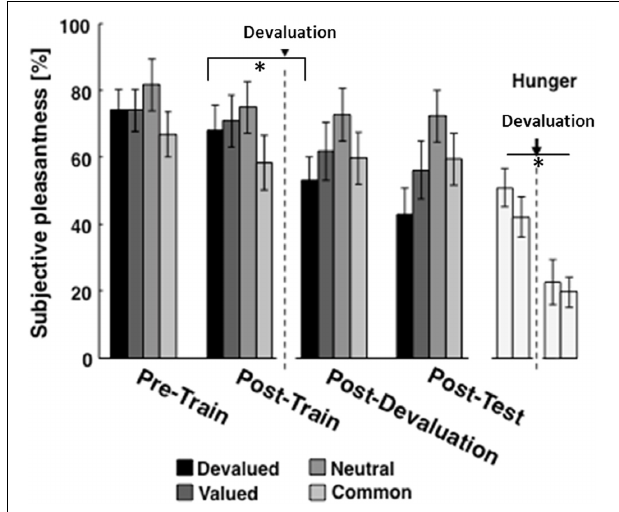
FIGURE 4 | Subjective pleasantness ratings for the devalued (chocolate or tomato), the neutral (water), and the common (fruit tea) outcome at 4 time points throughout the experimental procedure. After devaluation, participants rated the devalued food (chocolate or tomato) significantly (as indicated by ∗ ) less pleasant compared to the valued and neutral condition ( T = 2 . 67, p = 0 . 019). Further, they reported significantly less hunger after the devaluation procedure (panels display subjective hunger ratings at the 4 time points, T = 2 . 25, p = 0 . 042).